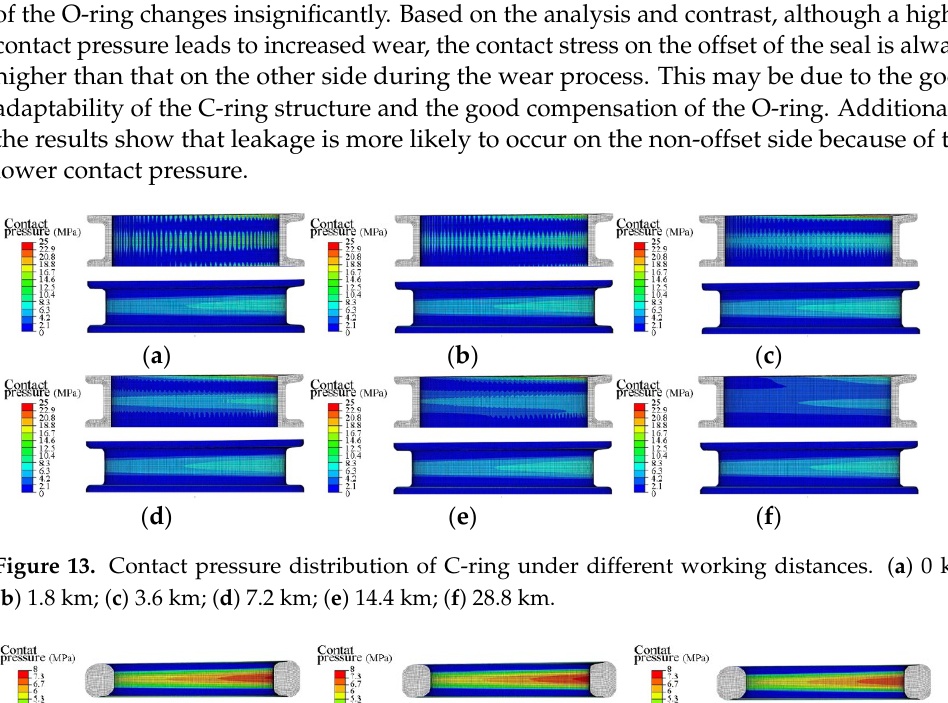
28.8 km. 28.8 km.